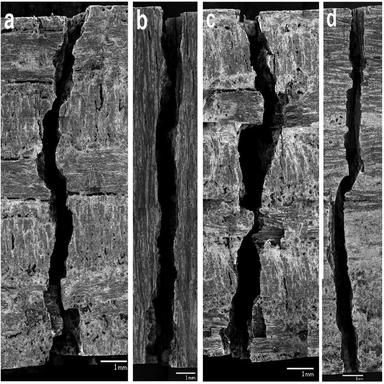
Low magnification SEM images of Cf-HfB2 powder composites after tensile testing at room temperature. (a) Strongest sample; cross-section (b) strongest sample; top surface, (c) weakest sample; cross-section, (d) weakest sample; top surface.